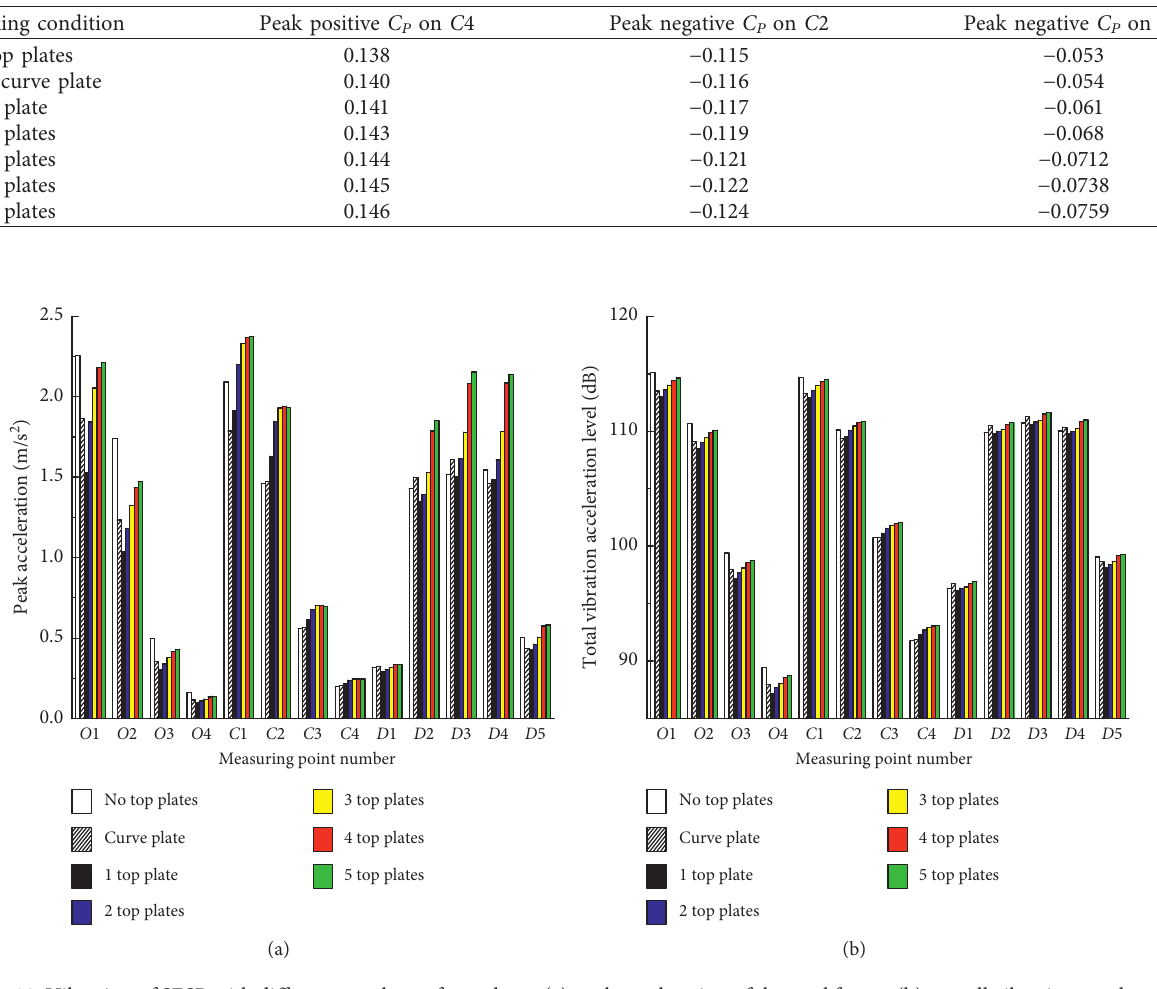
Figure 20: Vibration of SESB with different numbers of top plates: (a) peak acceleration of the steel frame; (b) overall vibration acceleration level of the steel